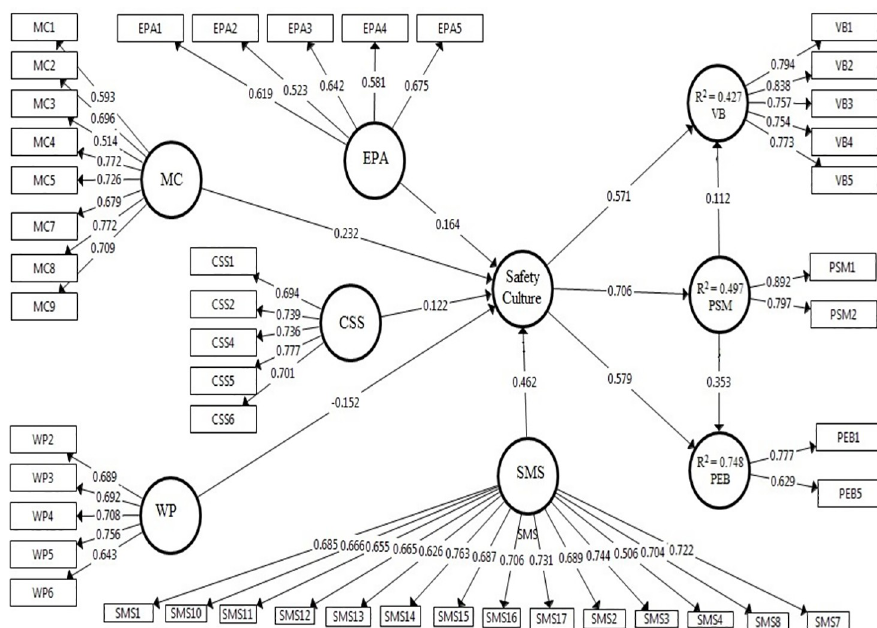
Fig 3. A final structural model with standardized path